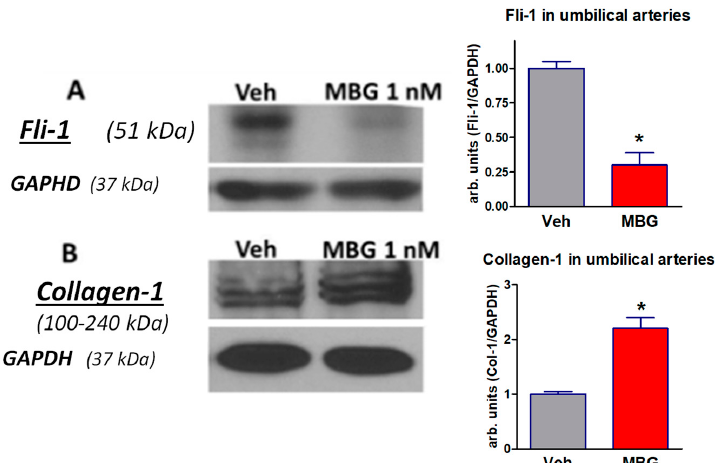
Figure 2. Western blots of Fli-1 ( A ) and collagen-1 ( B ) in placentae from normotensive pregnant subjects incubated with vehicle (grey columns) or 1 nM MBG (red columns). Left—representative Western blots, right—bars representing means ± SEM from 4 densitometry measurements. By t -test: * p < 0.01 vs. vehicle. Levels of Fli-1 and of collagen-1 were normalized against levels of GAPDH.